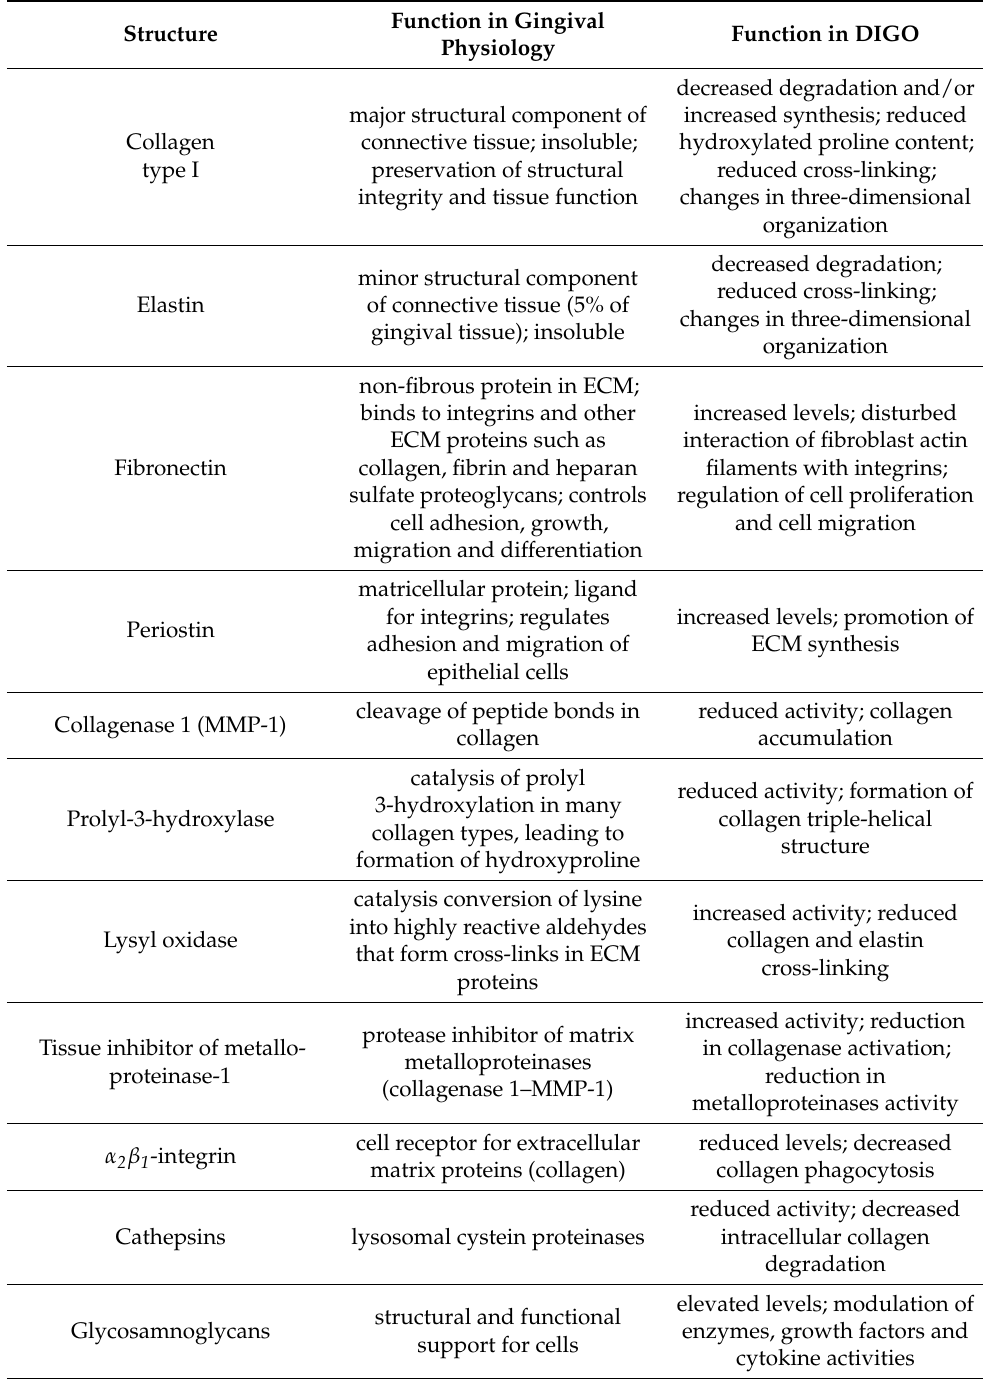
Table 3. Extracellular matrix (ECM) in